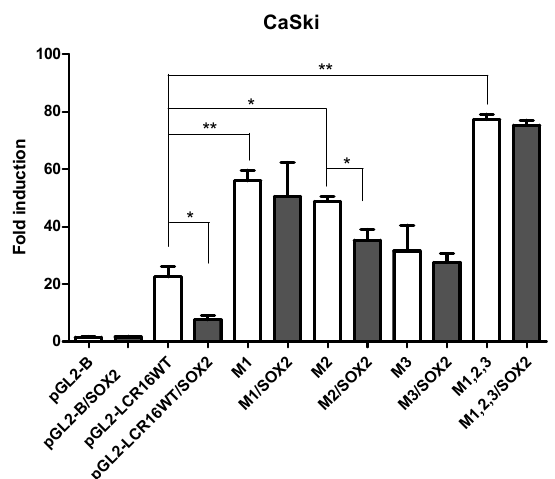
Figure 6. HPV16-LCR sites S1, S2 and S3 have a role in SOX2 repressor activity. Site directed mutagenesis was performed on the HPV16-LCR (wt, wild type) plasmid, generating M1 (LCR-Site 1 mutant), M2 (LCR-Site 2 mutant), M3 (LCR-Site 3 mutant) and M1,2,3 (LCR triple mutant) mutants. Transcriptional activity of luciferase reporter plasmids was measured in CaSki cells in the presence (black bars) or absence (white bars) of ectopically expressed SOX2. Fold induction of LCR16 activity was calculated in relation to the control vector pGL2-B. LCR16 mutant transcriptional activities were compared with pGL2-LCR16wt activity (white bars). Transcriptional activity of each LCR16 (wt, M1, M2, M3, or M1,2,3) was compared to its respective condition with and without SOX2 (white vs. black bars). Standard error of the mean is shown. * p < 0.05, ** p < 0.01.